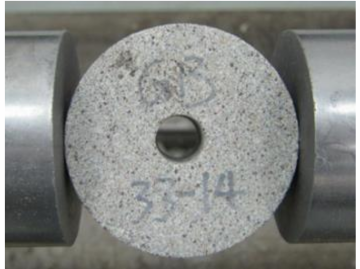
Figure 3. Clamping method of the